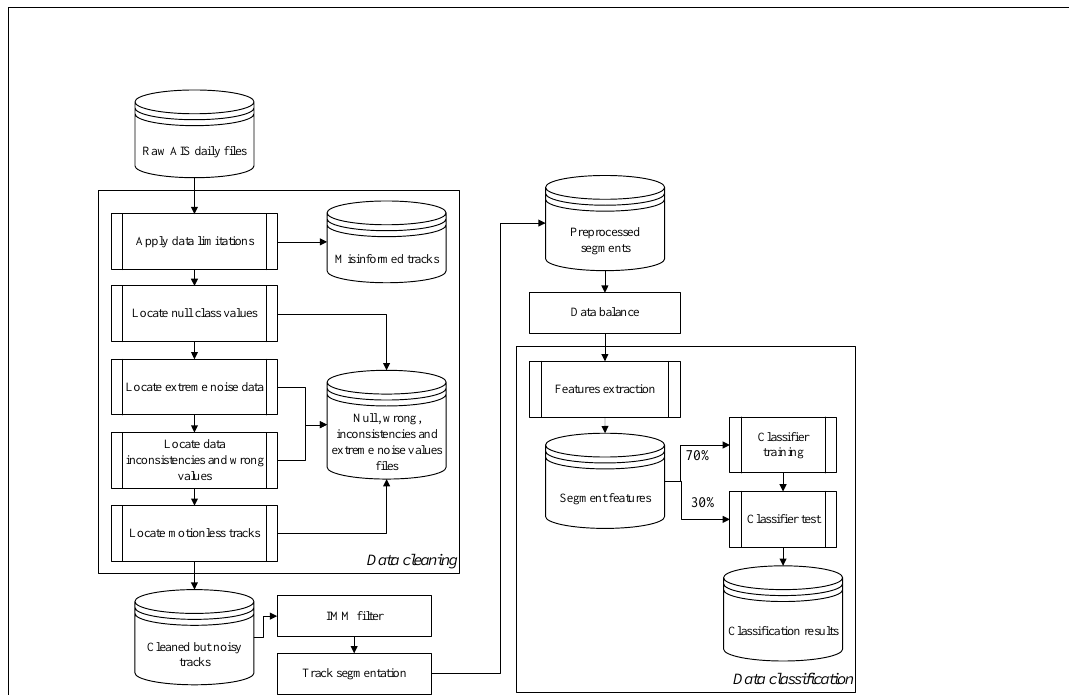
Figure 1. Architecture scheme. The code of the proposed architecture is publicly accessible at GitHub (https://github.com/DanielAmigo/trajectory-based-ship-classification).